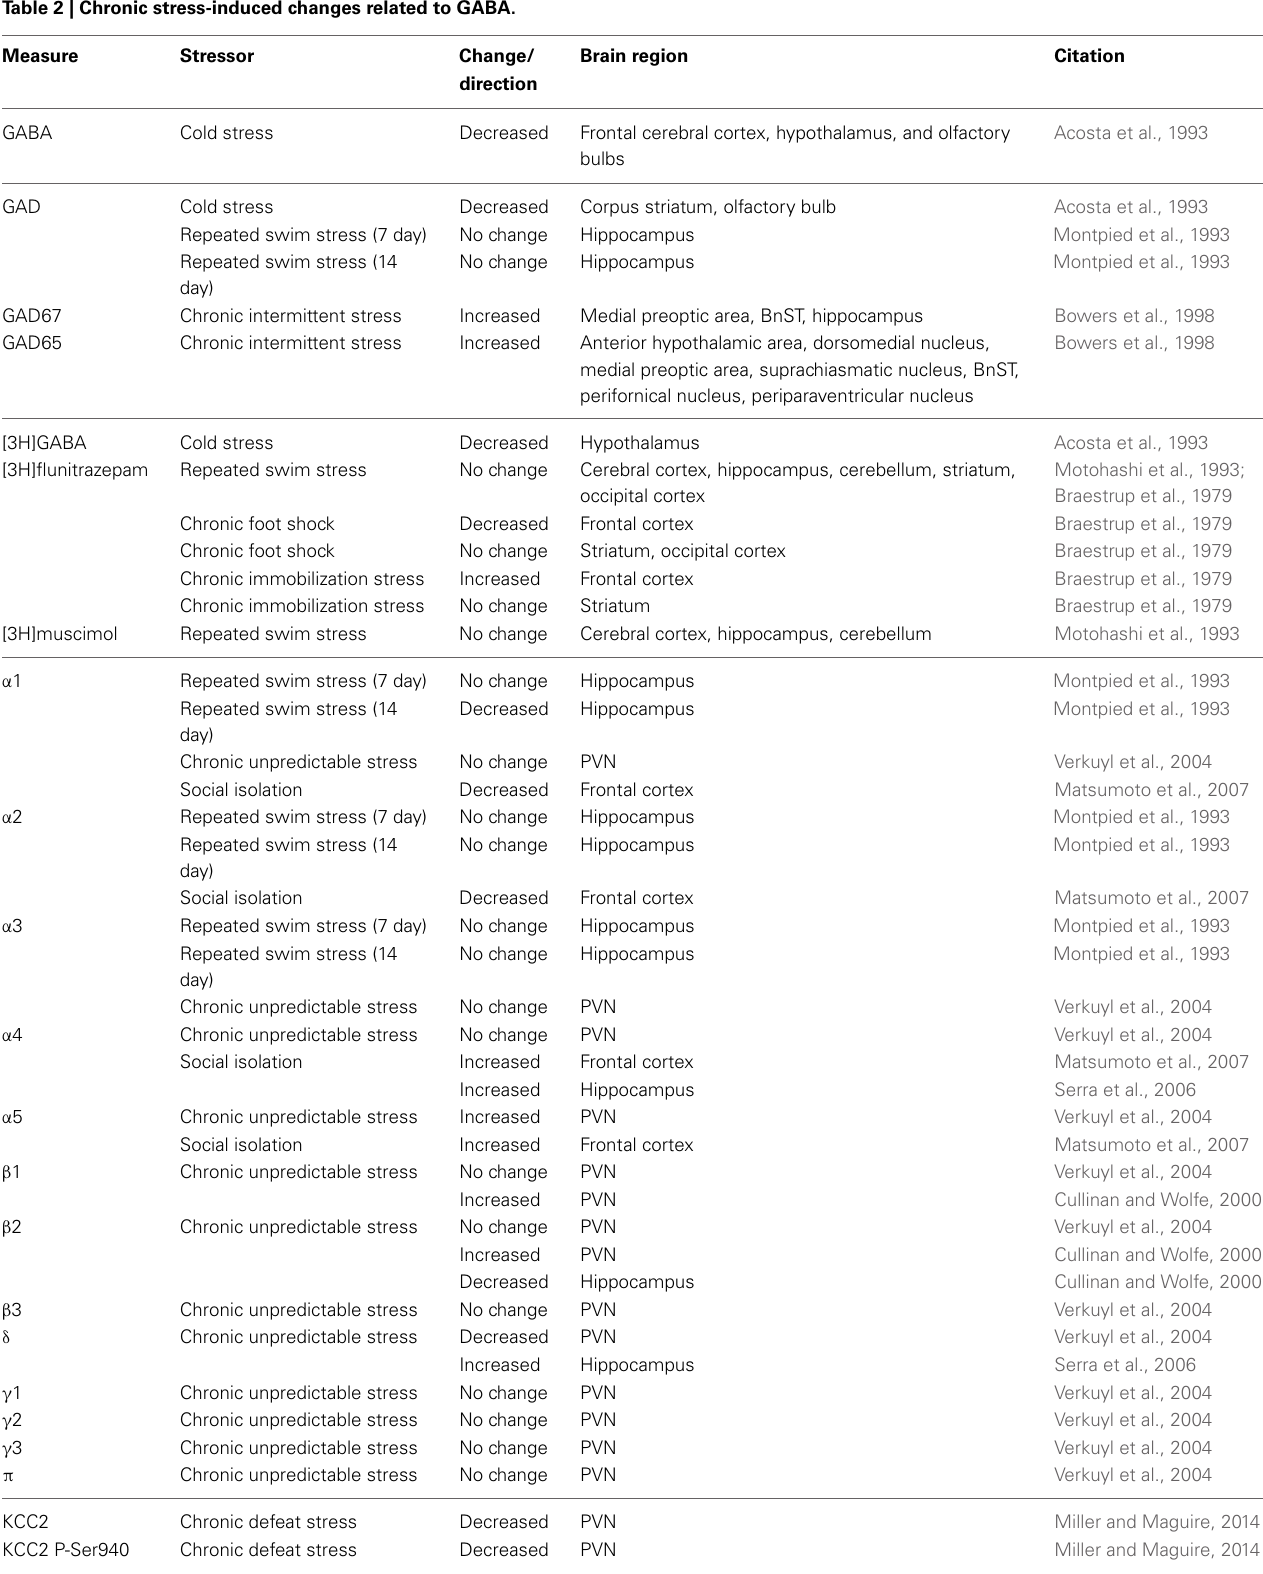
Table 2 | Chronic stress-induced changes related to